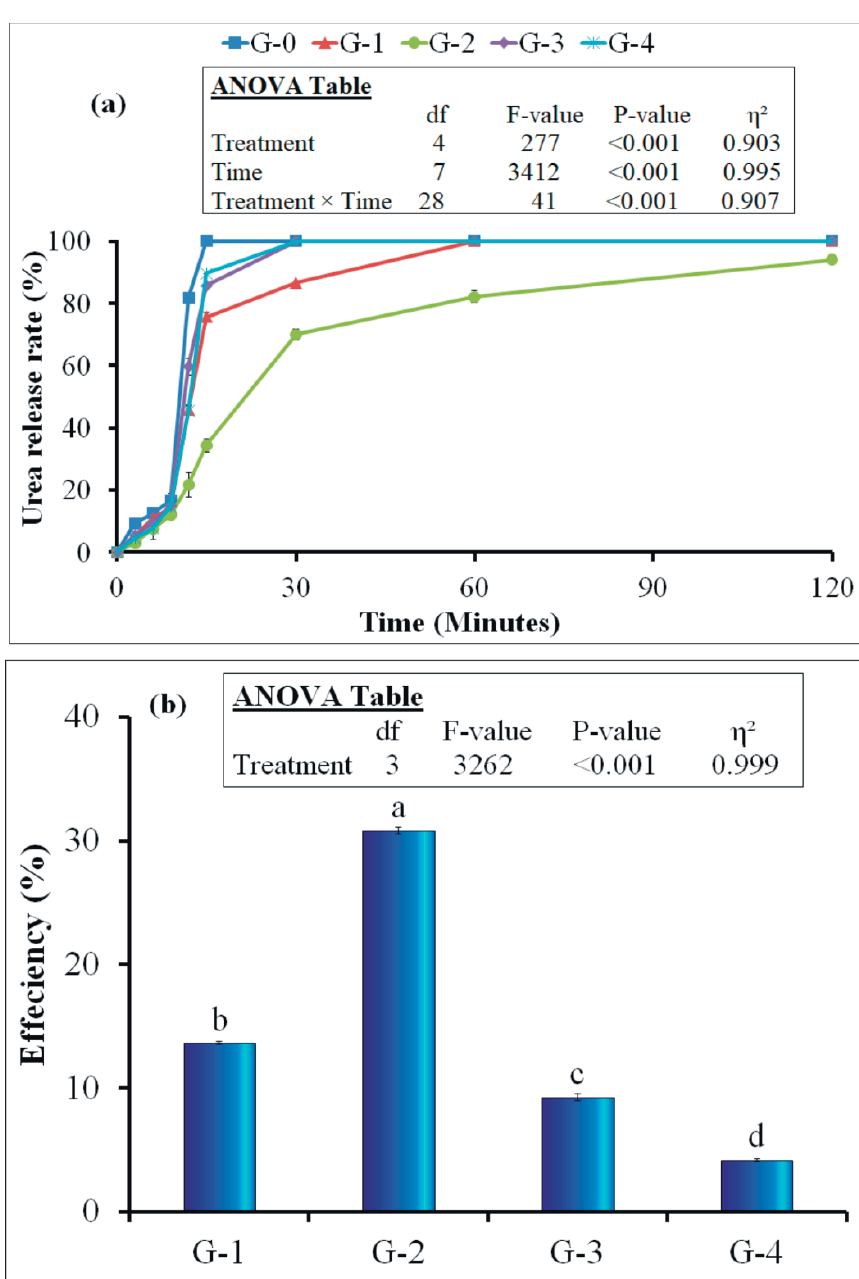
Figure 5. Release rate ( a ) and urea release efficiency ( b ) of granular urea. Abbreviations of different Figure 5. Urea Release rate ( a ) and urea release e ffi ciency ( b ) of granular urea. The symbols used for treatments can be seen in the caption of Figure 1. The small letters on bars indicate the difference various formulations can be seen in the caption of Figure 1. The small letters on error bars indicate among treatments at 5% probability level. Error bars shows standard error of the mean (n = 4). Insets the di ff erence among treatments at 5% probability level. The error bars indicates standard error of the in figures represent outcomes of the analysis of variance (ANOVA). mean (n = 4). Insets in the figures represent outcomes of the analysis of variance